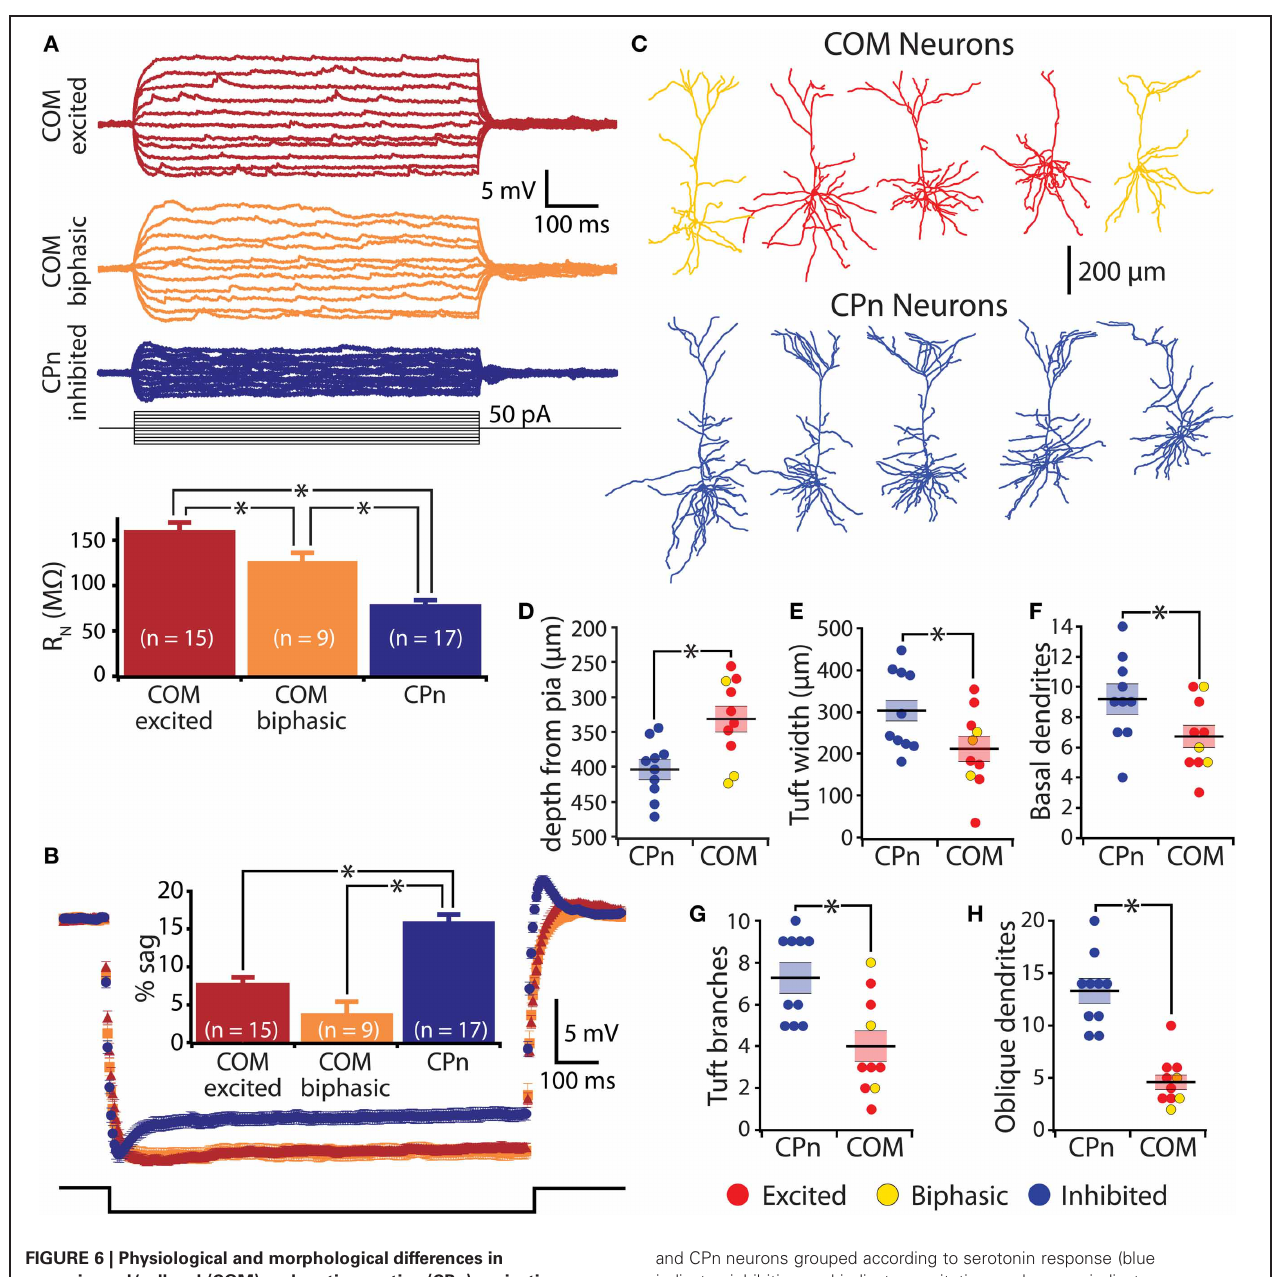
and CPn neurons grouped according to serotonin response (blue indicates inhibition, red indicates excitation, and orange indicates biphasic responses). Comparison of results is inset. (C) Representative morphologies of COM and CPn neurons. (D–H ) Comparisons of morphological properties in COM and CPn neurons ( n = 10 for each group). Response type of the neuron is color-coded, as indicated. Asterisks indicate p < 0 .